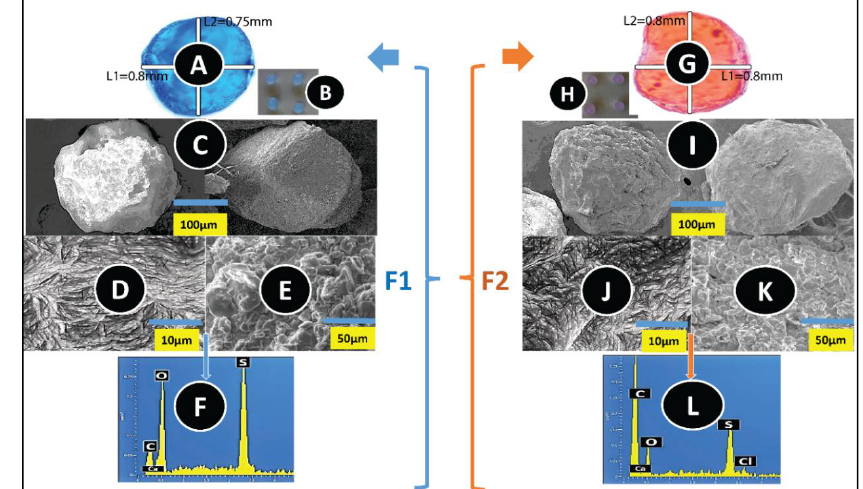
Figure 1. Morphological examination of microcapsules. ( A – B , G – H ) Optical microscopy. ( C , I ) electron